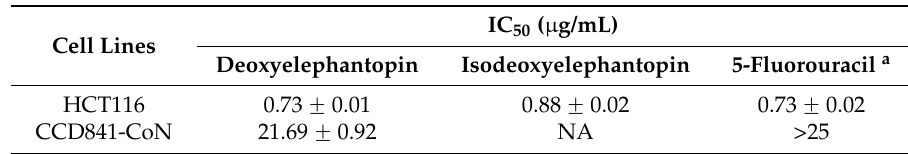
Table 3. IC 50 values of deoxyelephantopin, isodeoxyelephantopin and 5-fluorouracil against HCT116 cancer cell line and CCD841-CoN normal cell line at 72 h.